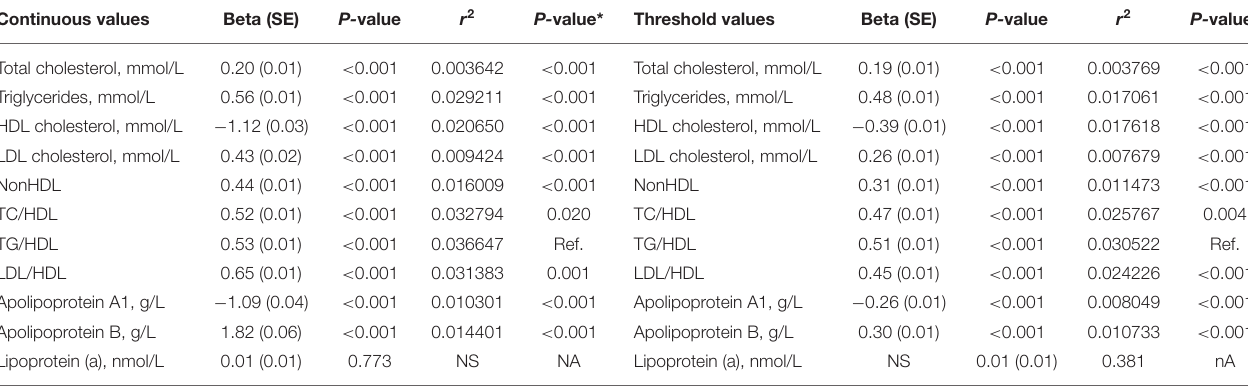
Apolipoprotein B, g/L